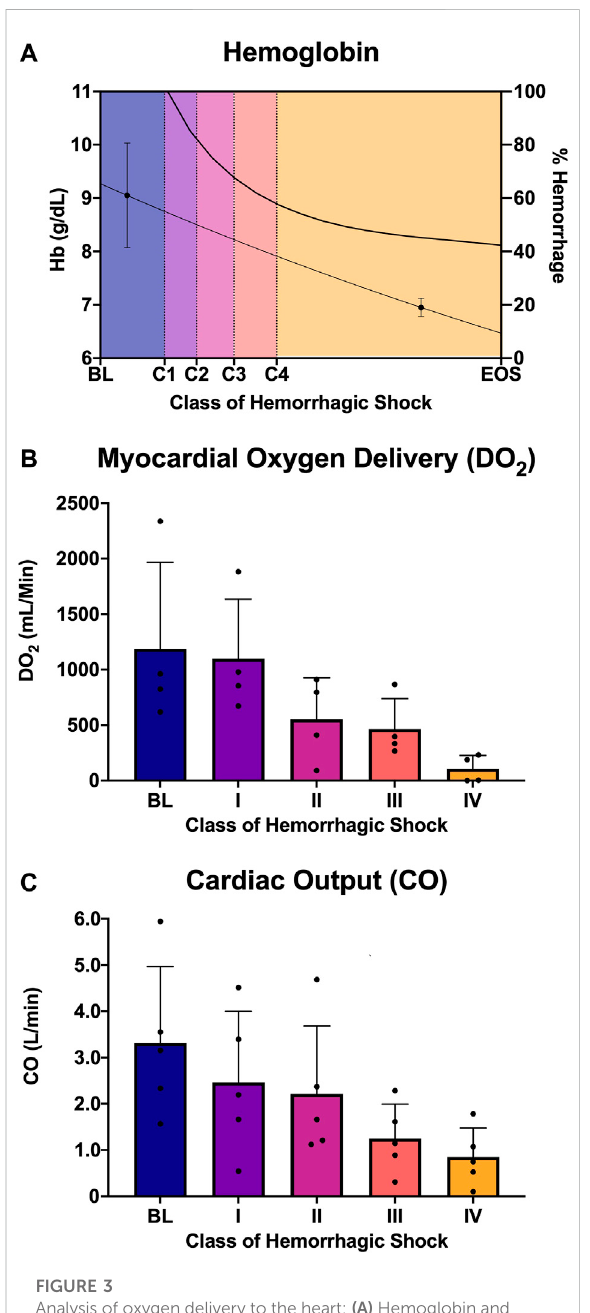
FIGURE 3 Analysis of oxygen delivery to the heart: (A) Hemoglobin and estimated percent of blood hemorrhaged from the logarithmic bleed at each study period, (B) myocardial oxygen delivery (DO2) from baseline and each class ofshock, and (C) cardiac output from baseline and each class of shock.